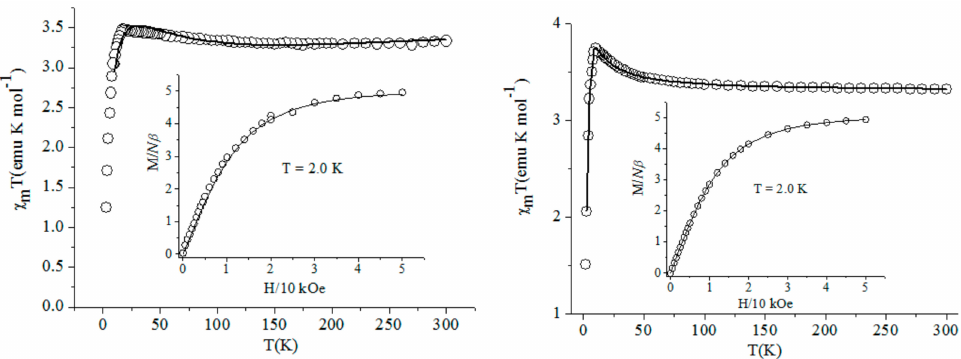
Figure 8. The magnetic property of complexes 3 and 5